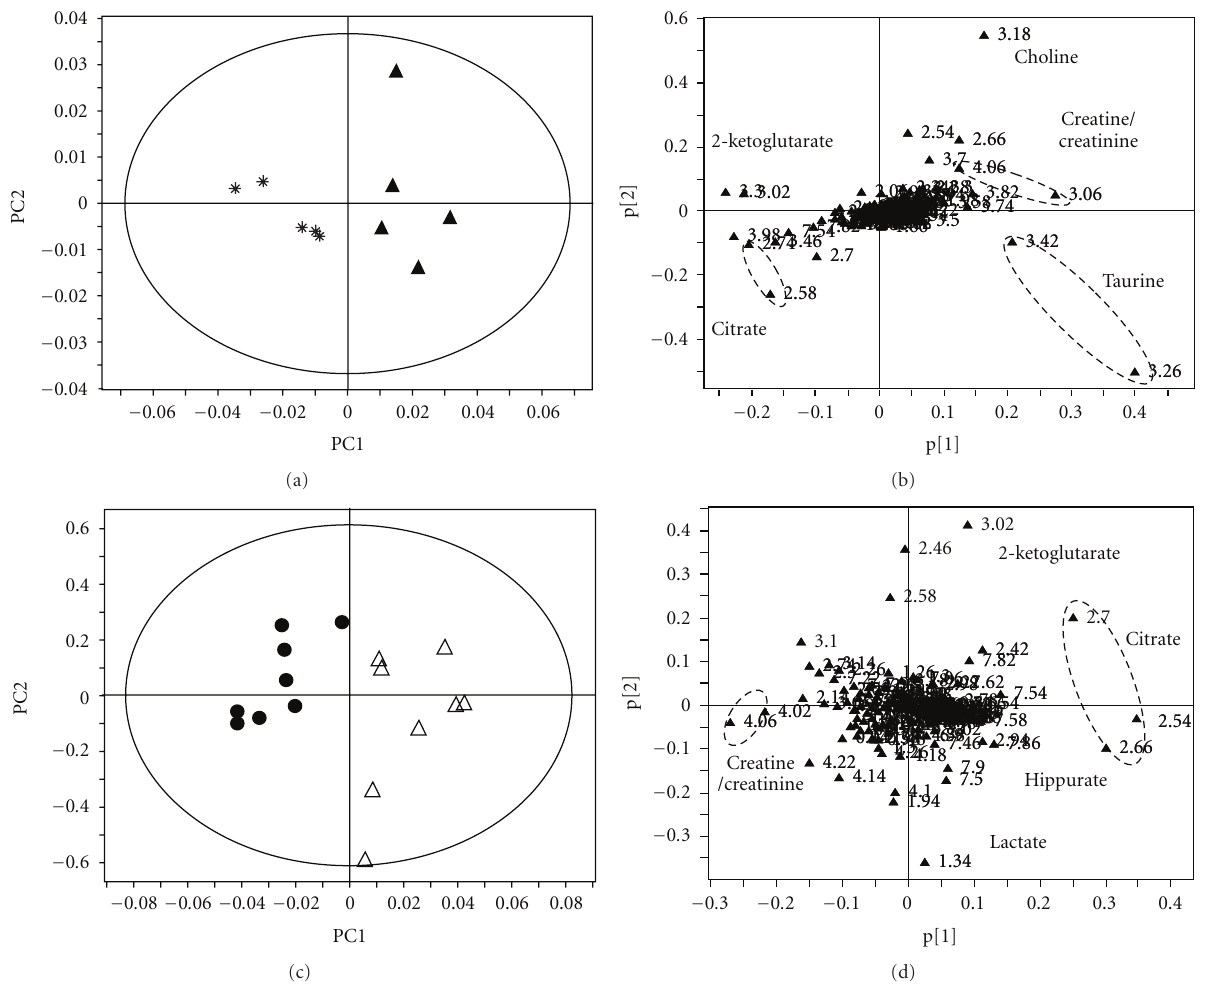
Figure 2: (a)-(b) PCA scores plot (PC1/PC2) and corresponding loading plot based on the 1 H NMR spectra of urine samples from Zucker lean rats ( ∗ ) and Zucker obese rats ( (cid:2) ), respectively. (c)-(d) PCA scores plot (PC1/PC2) and corresponding loading plot based on the 1 H NMR spectra of urine samples from Wistar rats ( (cid:3) ) and GK rats ( • ), respectively.